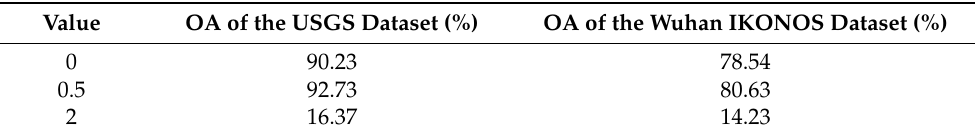
Table 5. Sensitivity analysis of r in the MOFH.